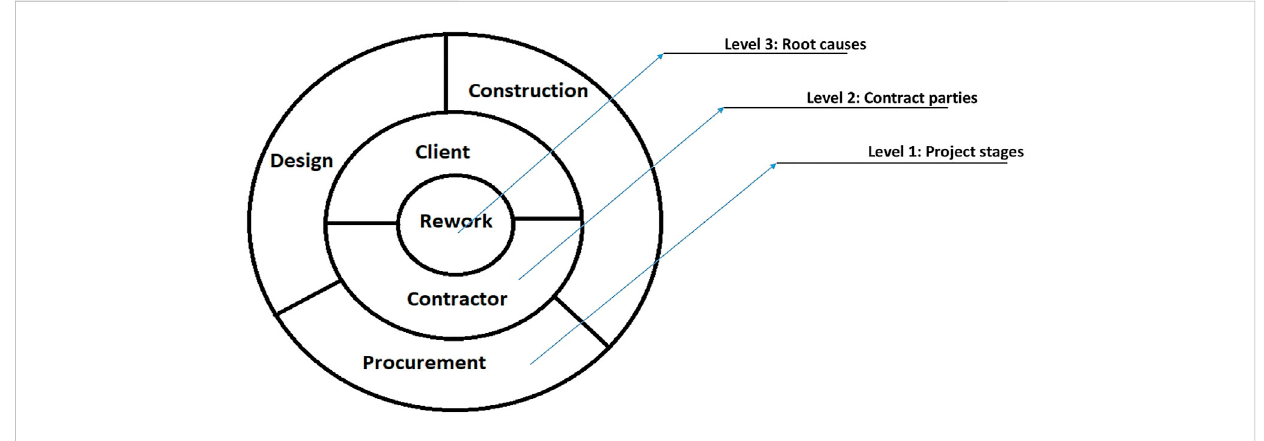
FIGURE 2 Conceptual structure for rework root causes classi fi